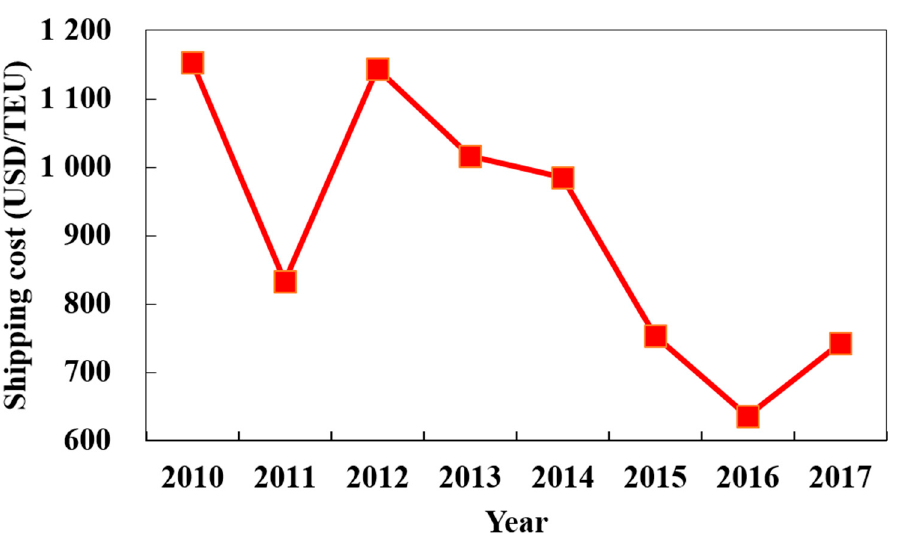
Figure 3. Shipping cost of 20 ′ container freight in 2010–2017. Source: plotted by authors based on data of [45].